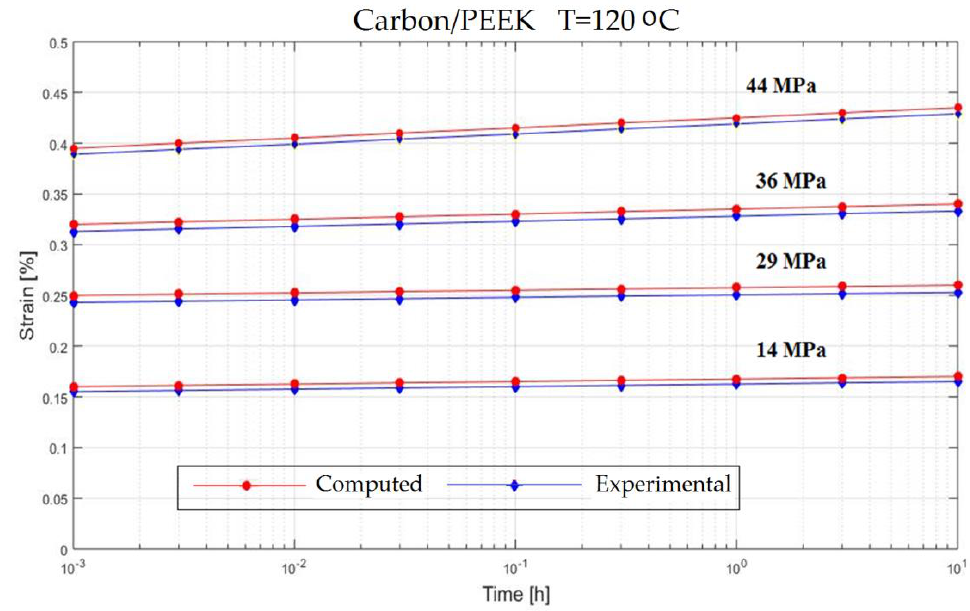
Figure 4. Creep response of a carbon/epoxy {90} 4s at T = 120 ° C.